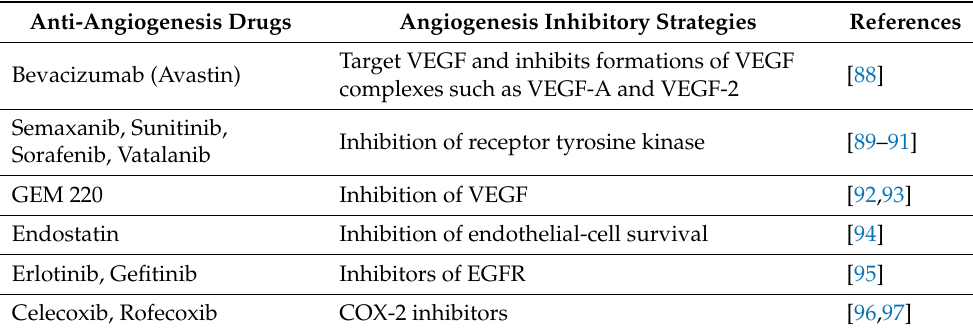
Table 4. Anti-angiogenic agents and some of their inhibitory strategies. Anti-Angiogenesis